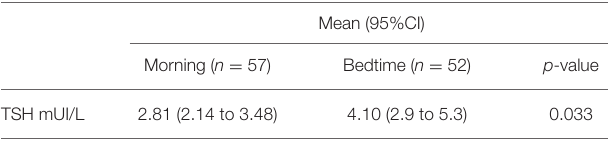
TABLE 4 | Effects of bedtime vs. morning levothyroxine intake in Thyroid-Stimulating Hormone (TSH) levels of participants using interfering drugs * 60min within levothyroxine administration (crossover